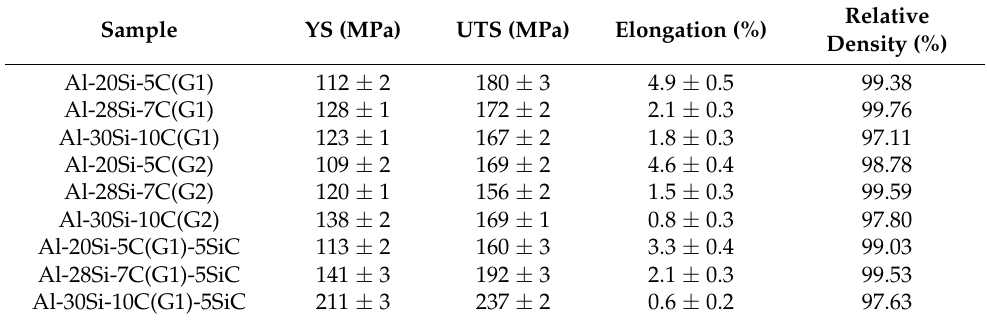
Table 2. Yield strength (YS), ultimate tensile strength (UTS), elongation, and relative density of samples.